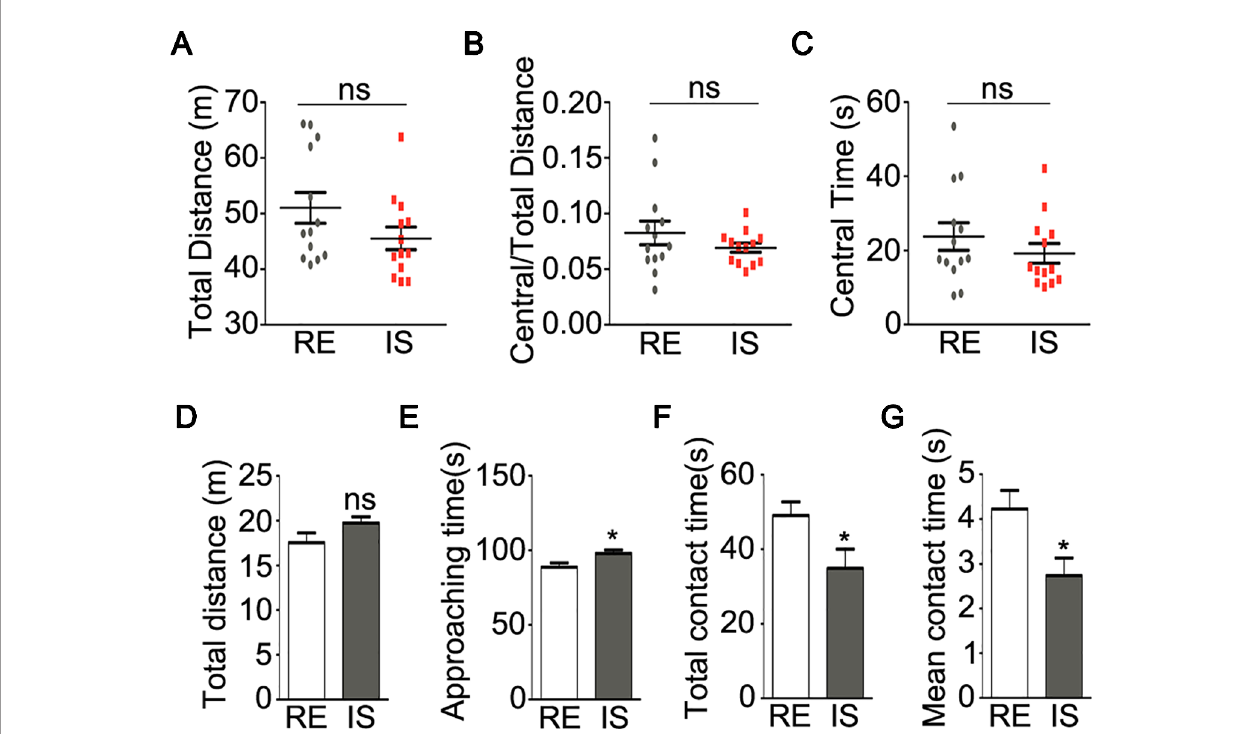
FIGURE 1 | Behavioral analyses of socially isolated mice. (A – C) locomotor activity of mice in open fi eld test (n = 13 for each group). Graphs show total distance (A) , ratio of central to total distance (B) and center time (C) in tested mice. (D – G) sociability of mice in social interaction test (n = 13 for RE group, n = 12 for IS group). Graphs show the total distance traveled (D) , duration of approaching to the stranger mice (E) , duration of total contact (F) and mean duration for each contact (G) in tested mice. RE, group-housed in regular environment; IS, social isolation. Data are expressed as mean ± SEM. *P < 0.05; ns, no signi fi cant